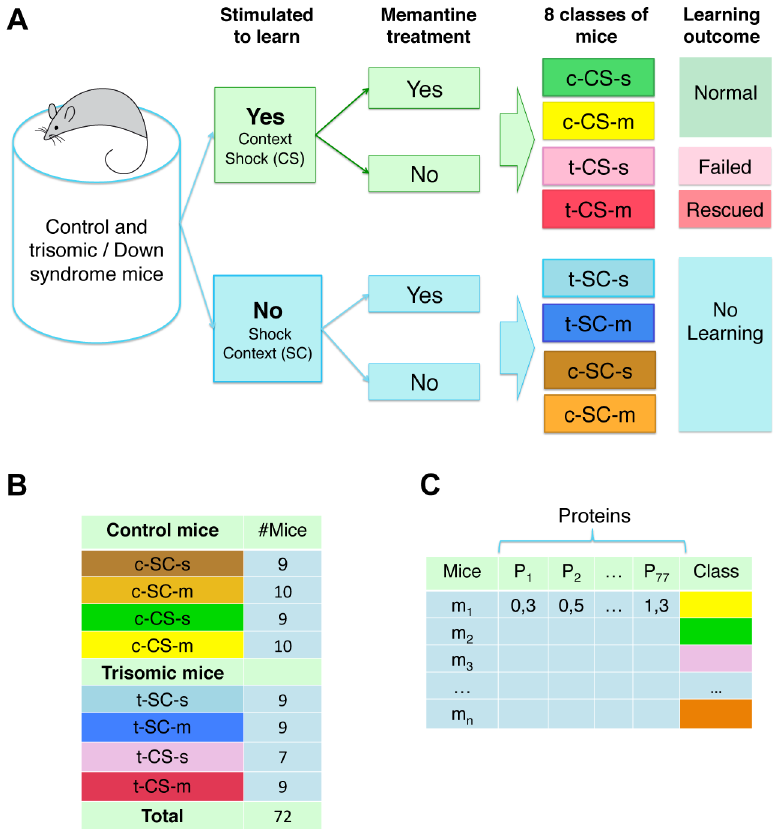
Fig 1. Classes of mice. (A) There are eight classes of mice based on genotype (control, c, and trisomy, t), stimulation to learn (Context-Shock, CS, and Shock-Context, SC) and treatment (saline, s, and memantine, m). Learning outcome indicates the response to learning for each class. (B) Number of mice in each class. (C) Format of protein expression data: rows are individual mice, and columns, P 1 ... P 77, are the measured levels of the 77 proteins. The color coding in the last column identifies each class; color coding was used in visualization of the SOMs but not in